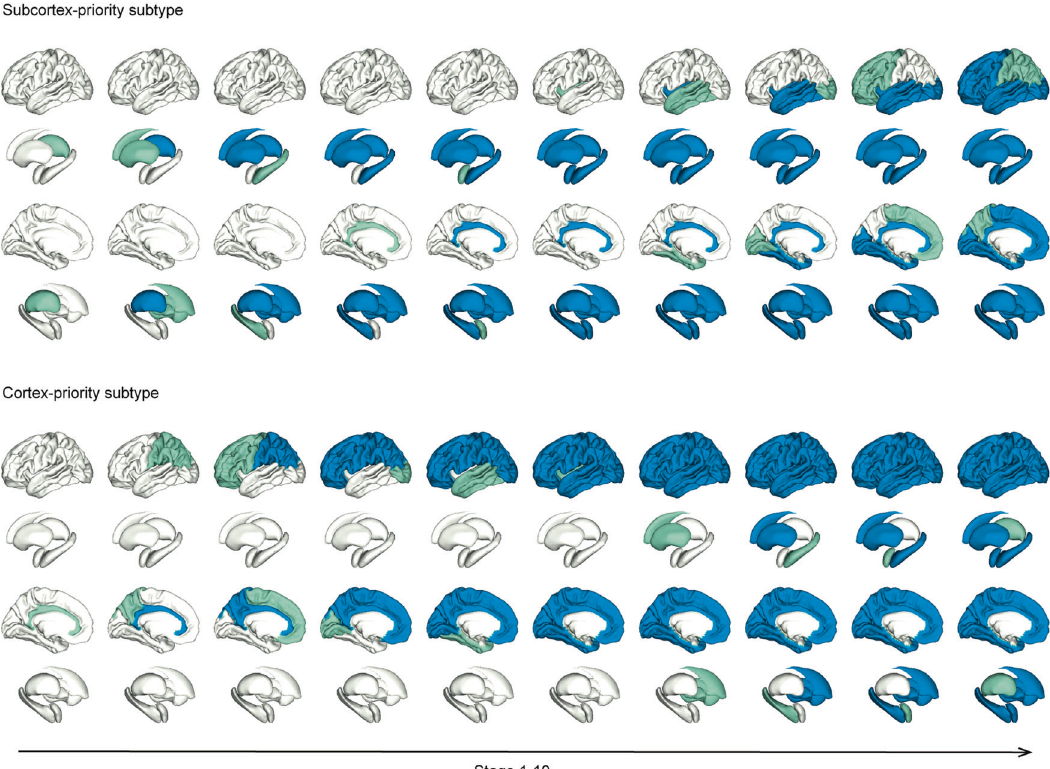
Fig. 2 Amyloid abnormality patterns reproduced in the validation dataset (ADNI1/GO/3). Green represents the abnormal regions in the numbered stage and blue indicates abnormal regions of the previous stage. The last stage, cerebellum, is not shown here. The progression pattern of amyloid abnormality in the subcortex-priority subtype evolves from the subcortical regions, over the cingulate and insula, to the cortical regions. The progression pattern of amyloid abnormality in the cortex-priority subtype evolves from the cingulate, to the cortical regions, to the insula, and fi nally to the subcortical